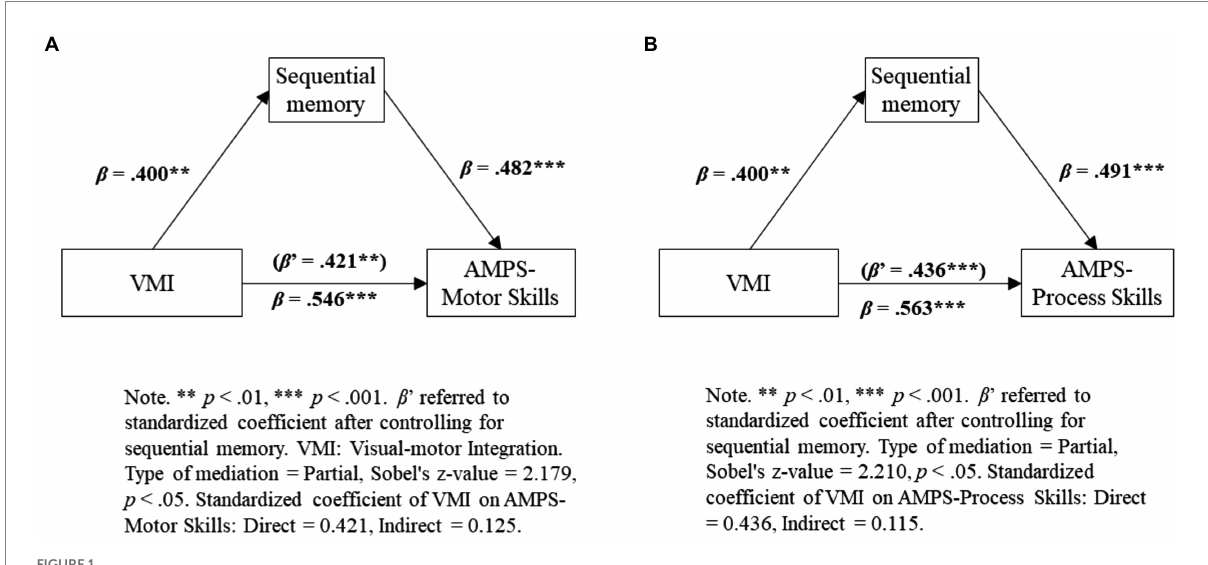
FIGURE 1 (A) and (B) Results of testing for mediation by sequential memory on relationship between visual-motor integration and self-care